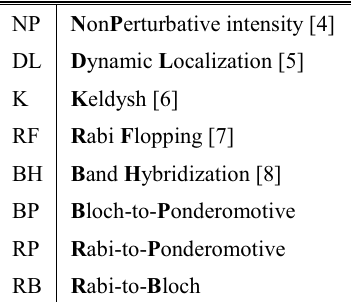
Table 2. Acronyms of adiabaticity parameters and their